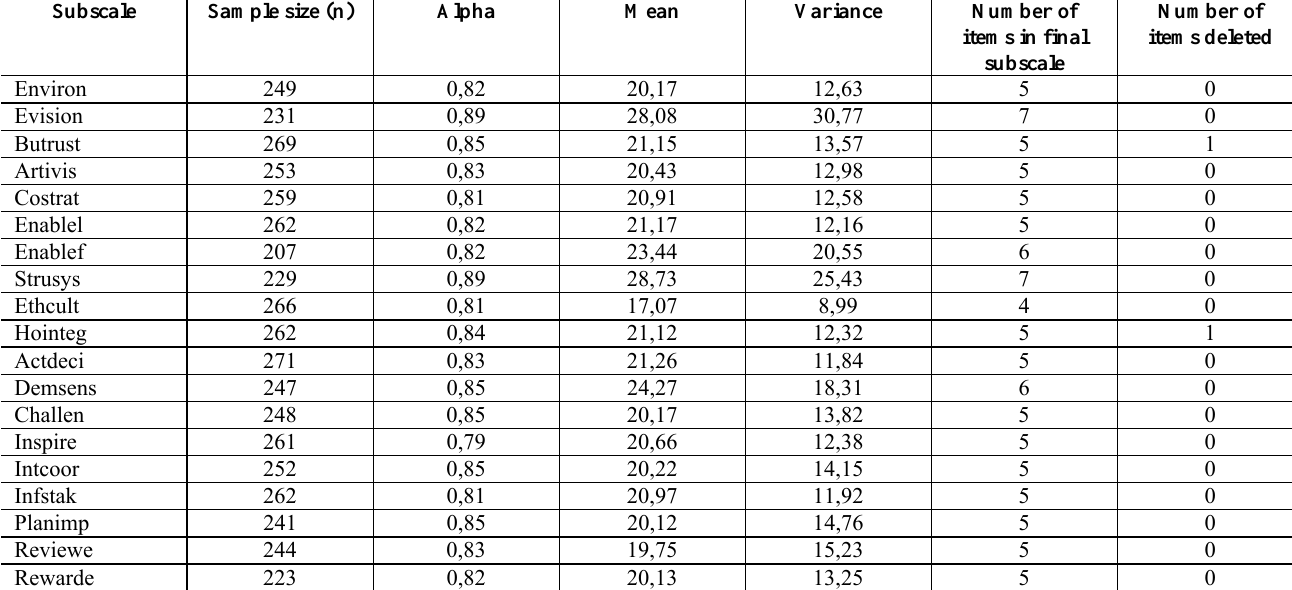
Table 6: Reliability of ELI sub-scale measures